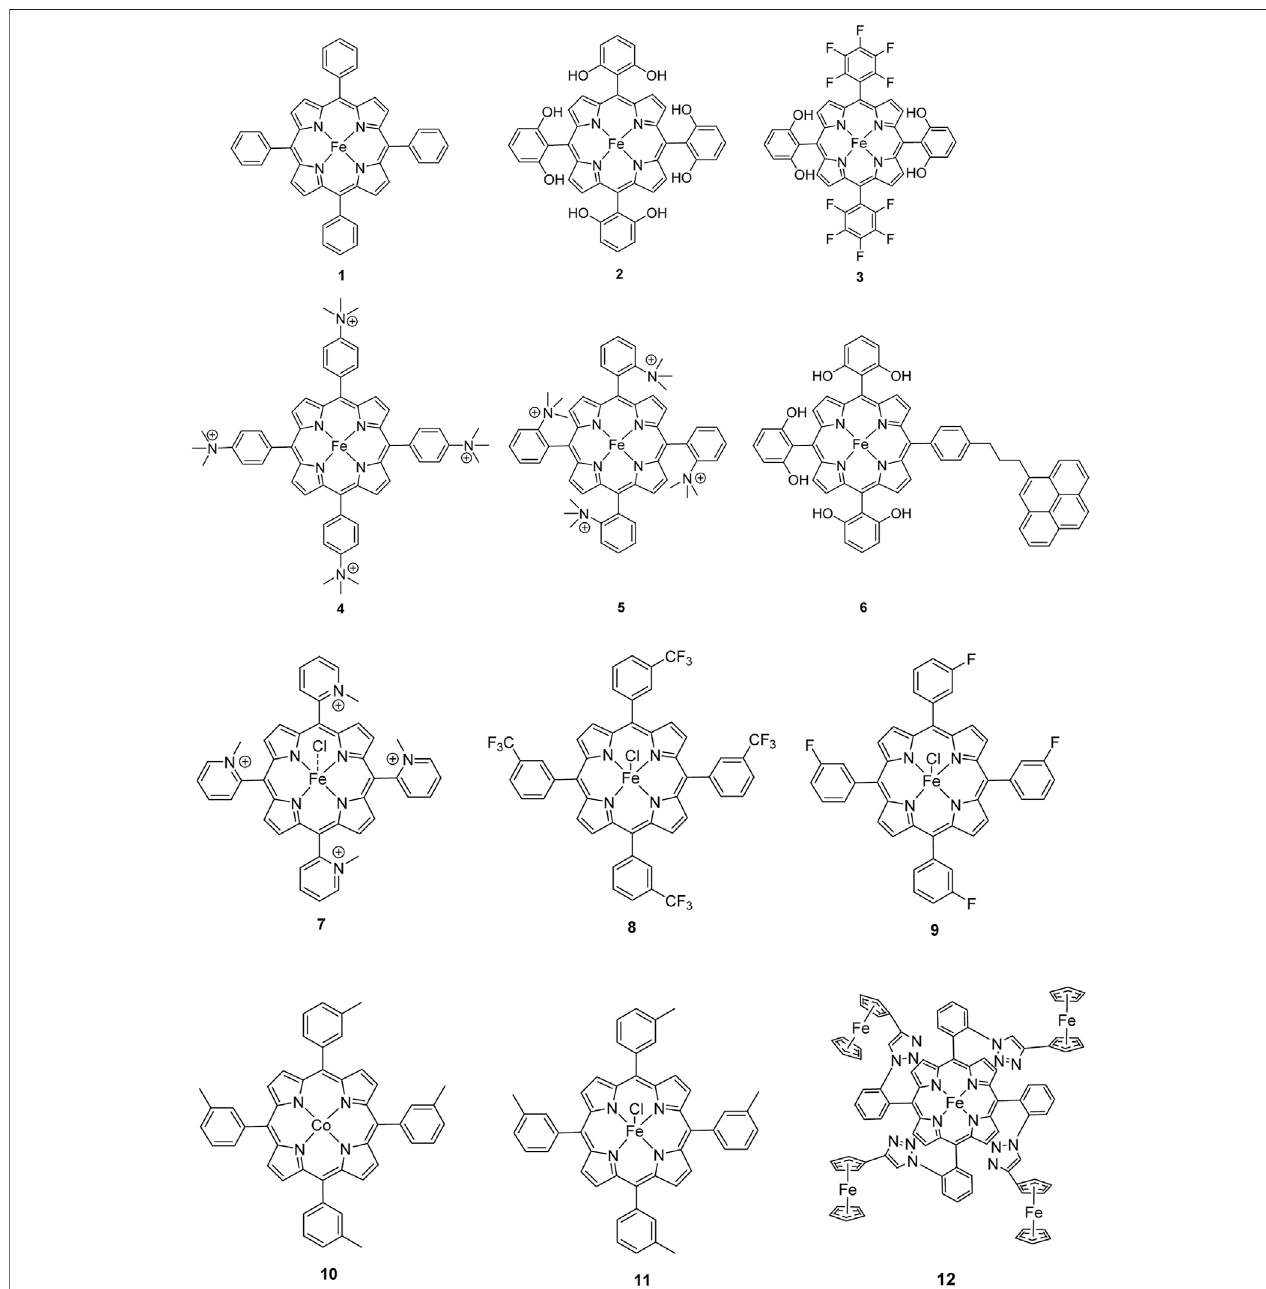
FIGURE 4 | Examples of Fe − and Co-Porphyrin complexes for CO 2 reduction to CO (Mondal et al., 2019).